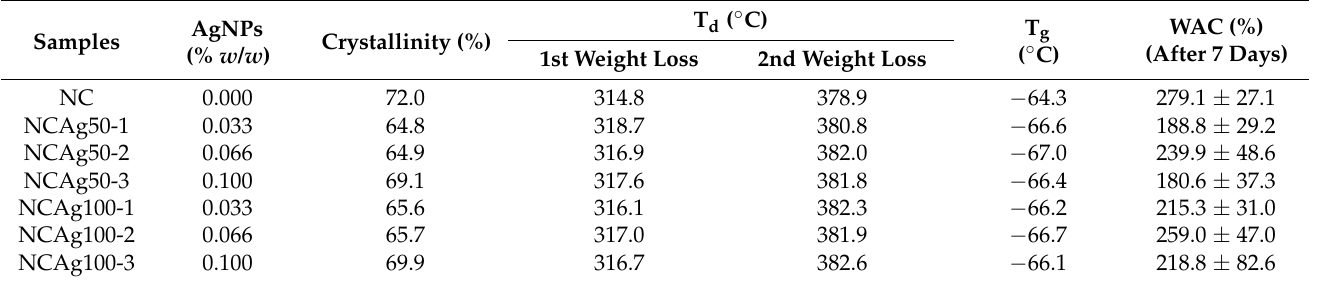
Figure 5. XRD patterns of NC, NCAg50, and NCAg100 films. Table 2. Degree of crystallinity, decomposition temperature (T d ), glass transition temperature (T g ), and water absorption capacity (WAC) of NC, NCAg50, and NCAg100 films.